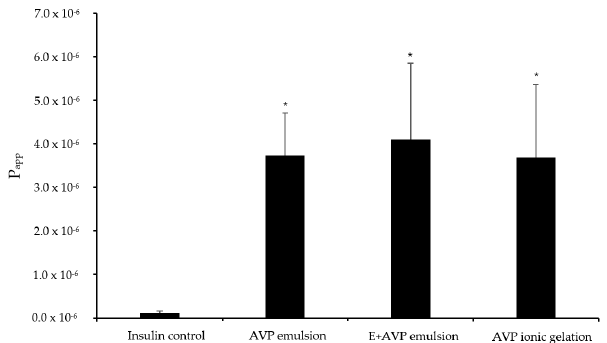
Figure 3. Apparent permeability coefficient (P app ) values for insulin across excised olfactory sheep nasal epithelial tissues after application of the microparticle formulations and insulin alone (control group). AVP emulsion = insulin microparticle formulation prepared by emulsion-solvent evapo- ration consisting of A. vera polysaccharides, E + AVP emulsion = emulsion-solvent evaporation with Eudragit ® L100 and A. vera polysaccharide, and AVP ionic gelation = insulin microparticle formulation prepared by ionic gelation with A. vera polysaccharides. * Statistically significantly different from the control group ( n = 6; p <